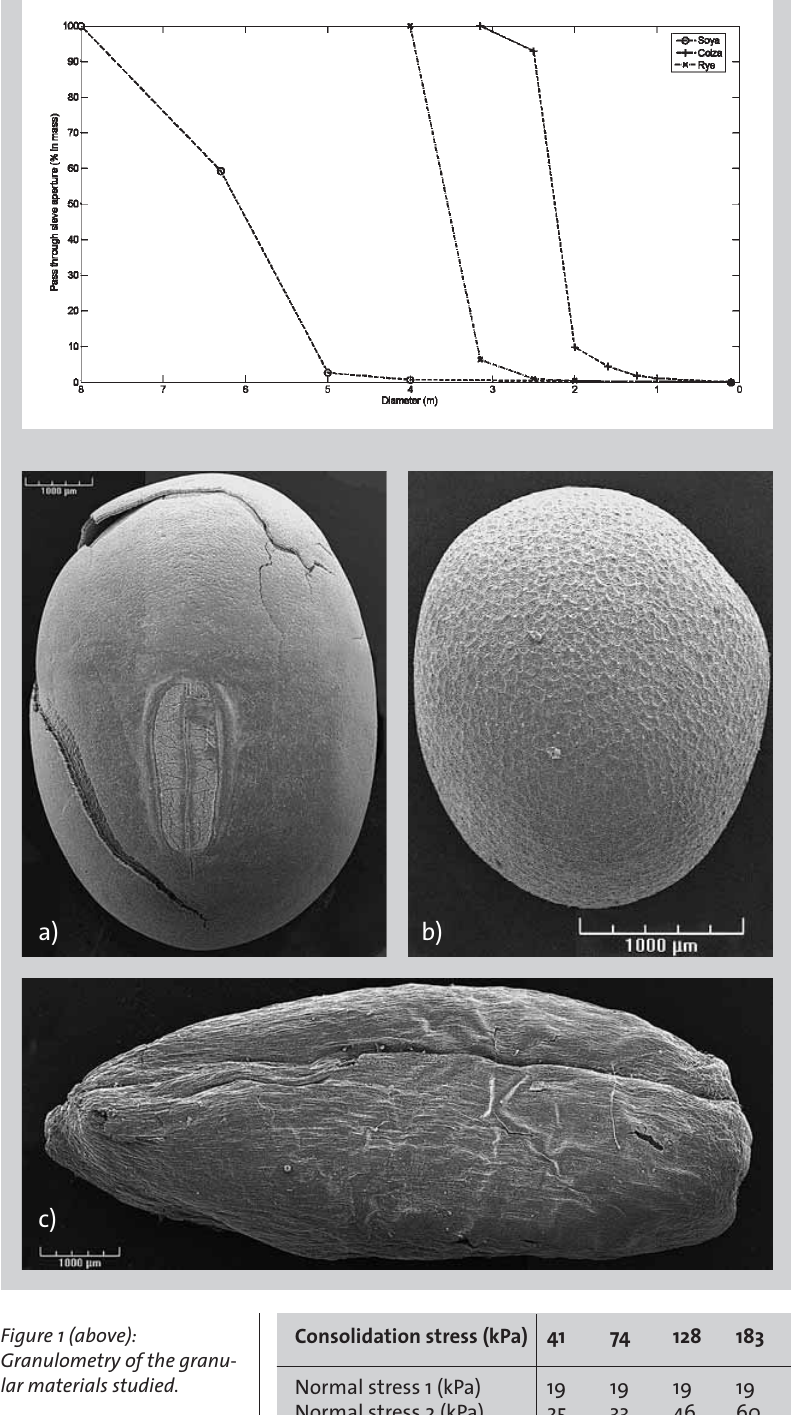
Figure 1 (above): Granulometry of the granu- lar materials studied. Figure. 2: SEM images of the granular materials tested: a) soya, b) colza, and c) rye. Table 1: The applied normal stresses and the corresponding con- solidation